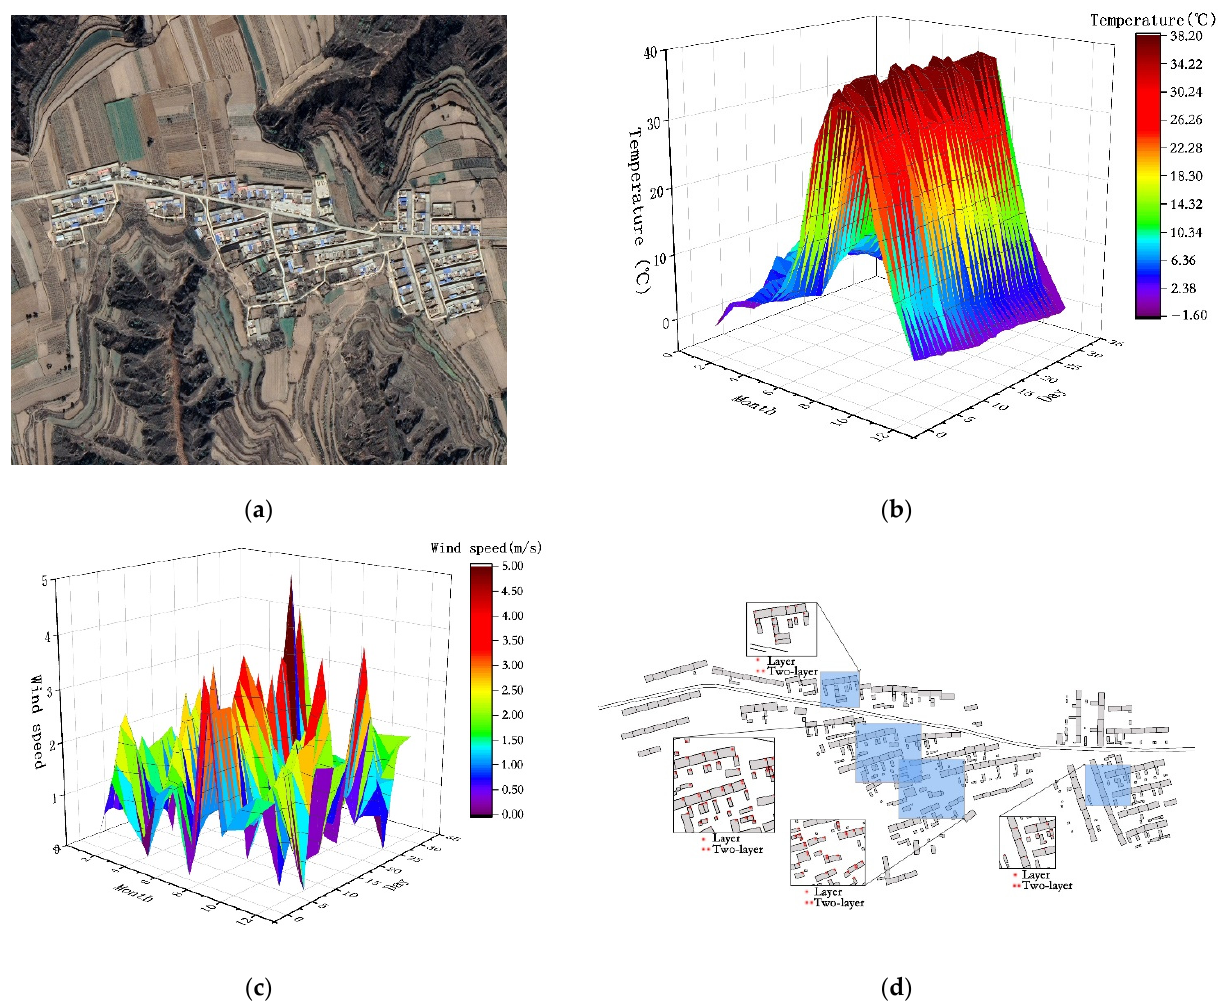
Figure 1. ( a ) Topographic satellite map of Hong village. ( b ) Annual temperature distribution map. ( c ) Distribution map of wind velocity throughout the year. ( d ) Village plan.